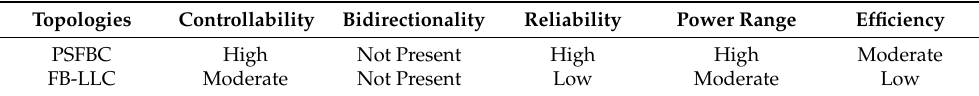
Table 6. Functionalities comparison of onboard charging rectifiers.